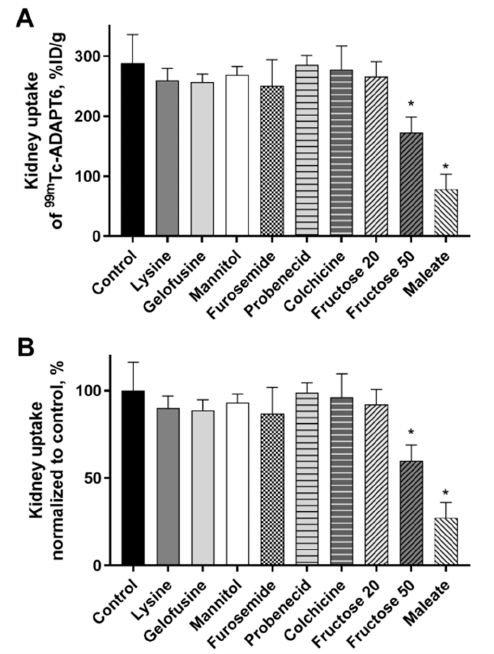
Figure 2. Kidney uptake of radiolabeled [ 99m Tc]Tc(CO) 3 -ADAPT6 4 h p.i. in female NMRI mice treated with di ff erent compounds. ( A ) The kidney uptake of [ 99m Tc]Tc(CO) 3 -ADAPT6 in %ID / g of kidney. ( B ) The kidney uptake of [ 99m Tc]Tc(CO) 3 -ADAPT6 normalized to control taken as 100%. The uptake was decreased when 50 mmol / kg fructose or maleate were administered 5 min before the ADAPT6. Data are presented as average from four mice ± SD. An asterisk marks a significant di ff erence from the control (* p < 0.0001, one-way